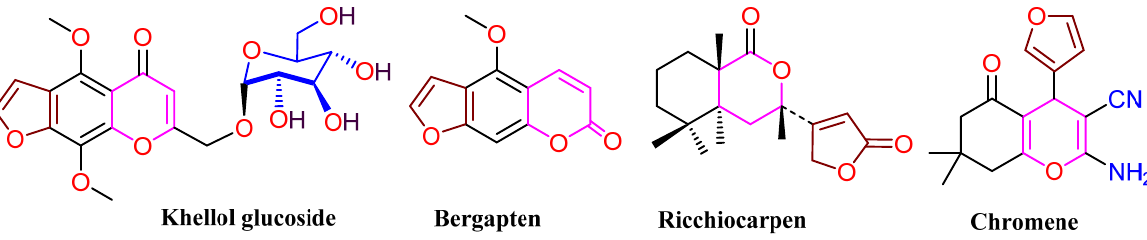
Figure 1. Furochromones and chromene derivatives with biological and pharmacological activities.